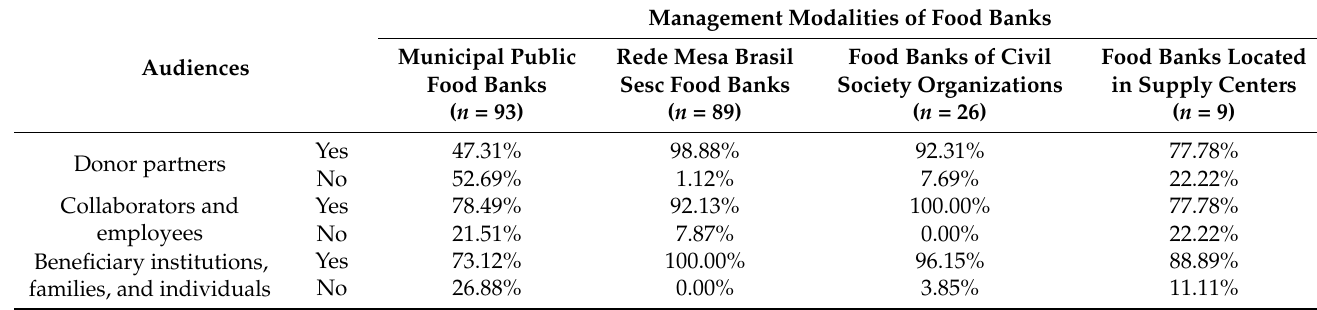
Table 5. Types of beneficiaries attended by Brazilian food banks in 2019 ( n = 217).